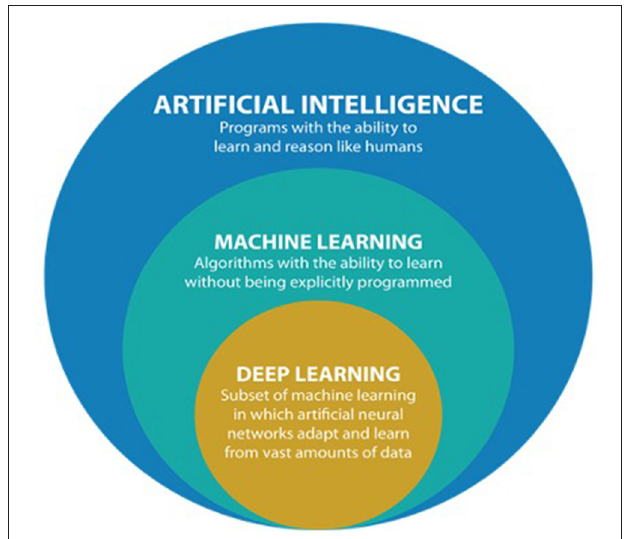
FIGURE 1 | Comprehensive overview of artificial intelligence (AI) and its subfields (from https://datacatchup.com/artificial-intelligence-machine- learning-and-deep-learning/).